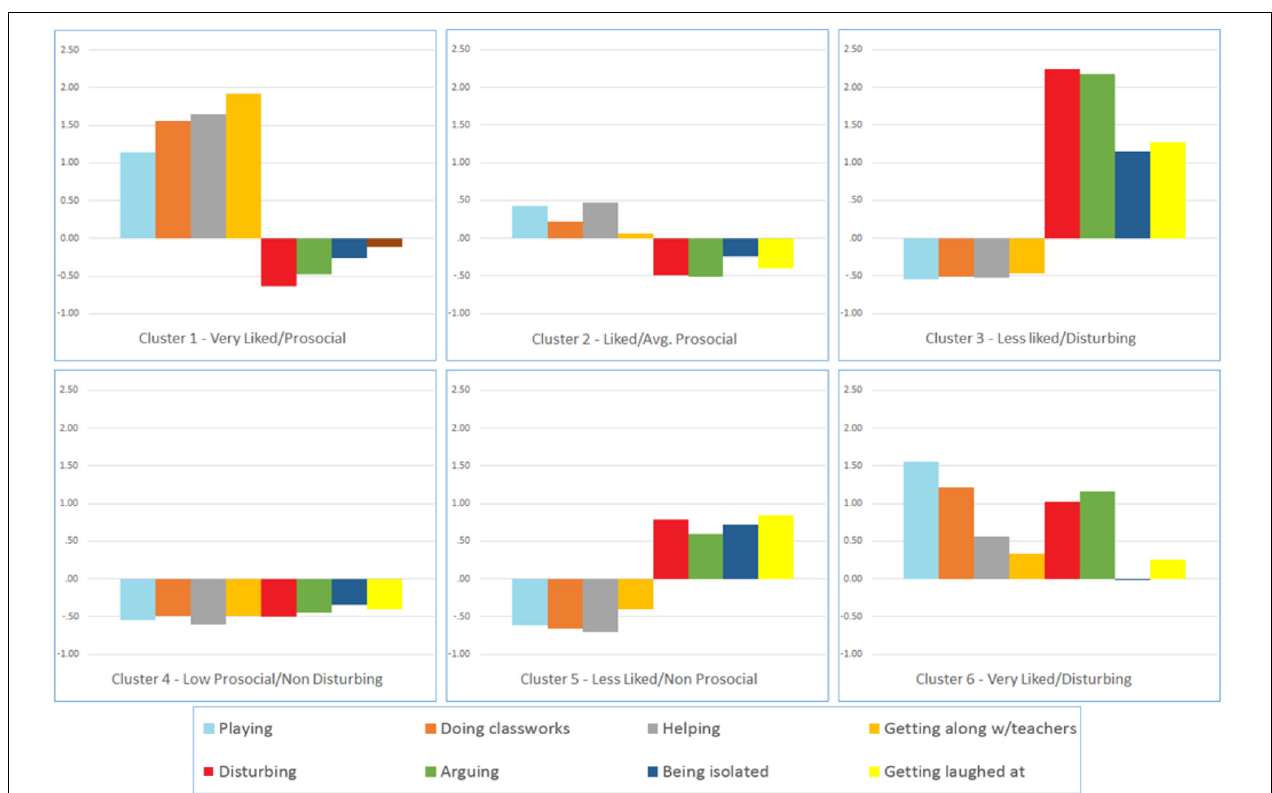
FIGURE 1 | Cluster mean values for standardized peer nomination variables. Cluster 1 ( n = 52, 12.3%), cluster 2 ( n = 111, 26.2%), cluster 3 ( n = 41, 9.7%), cluster 4 ( n = 142, 33.5%), cluster 5 ( n = 59, 13.9%), and cluster 6 ( n = 19,